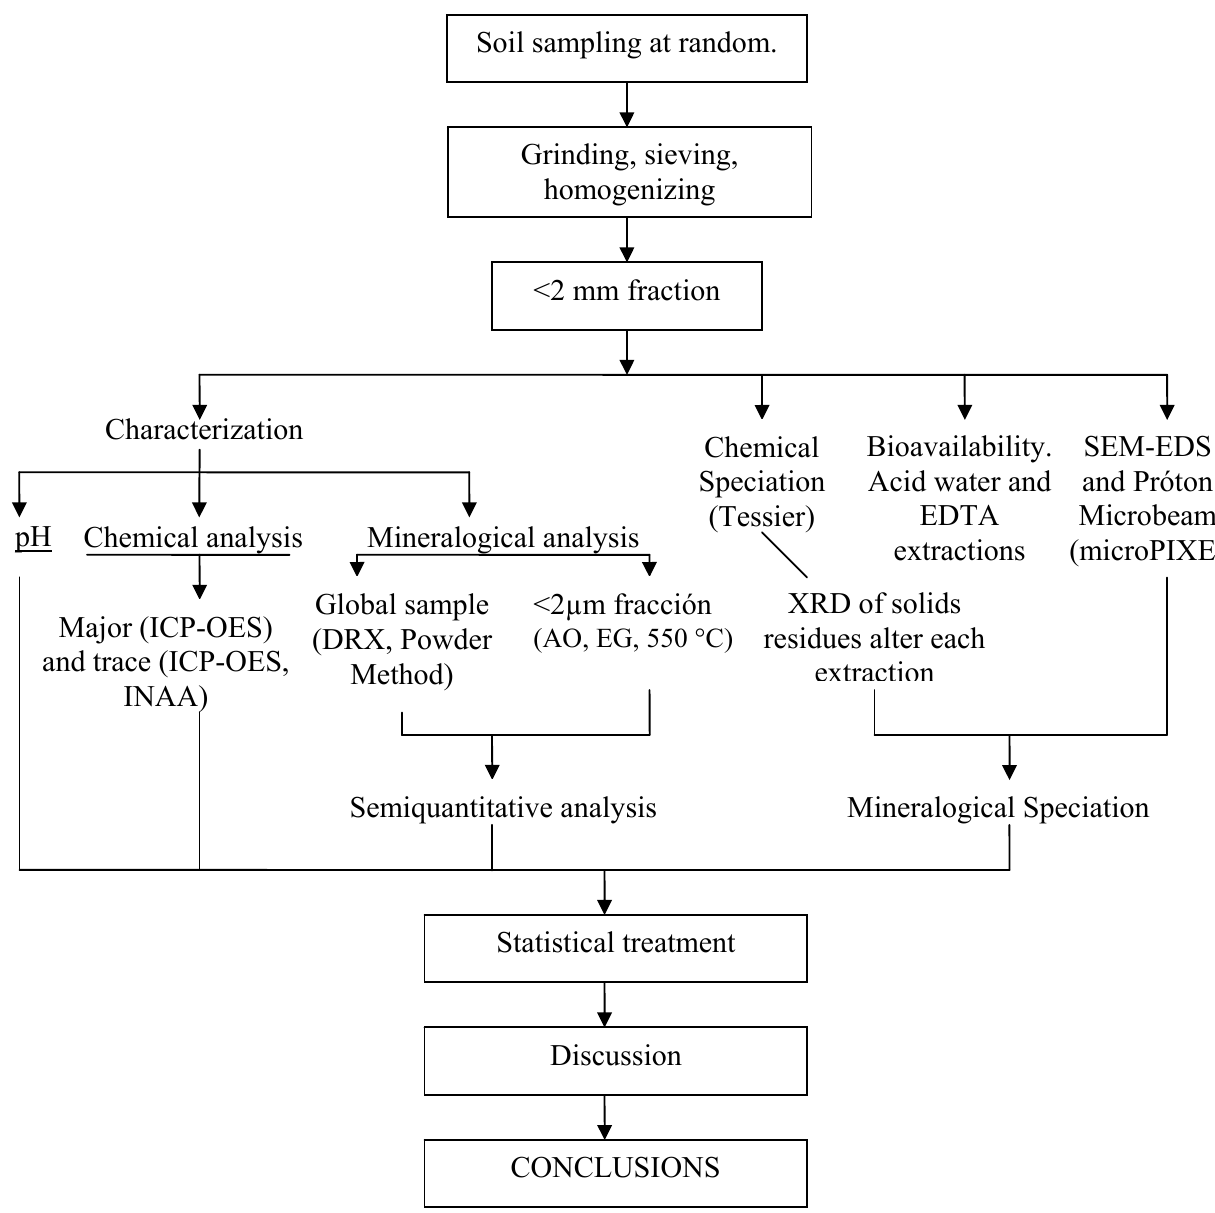
Figure 2. Methodological approach followed in this